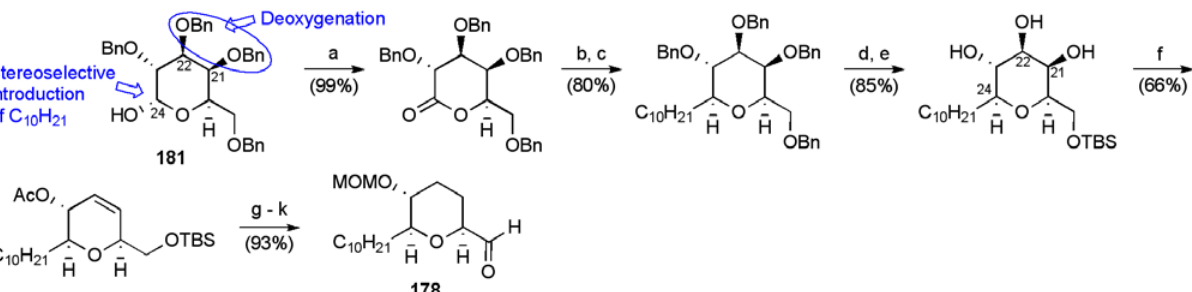
Scheme 42. Synthesis of THP fragment 178